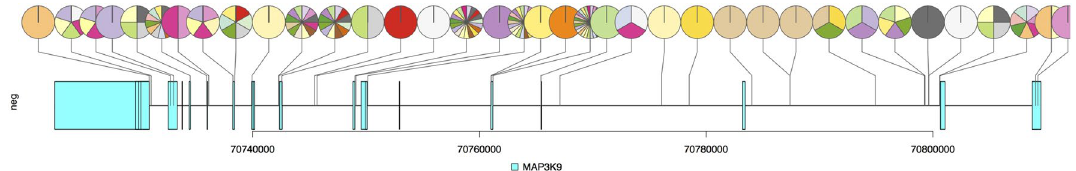
Figure 1. Genomic locations of SNVs in MAP3K9 . Figure 1 demonstrates the large number and locations of SNVs across the MAP3K9 gene. Exons are depicted as blue blocks. Thirty-seven unique SNVs were observed in total. Each pie chart portrays the number of patients who were found to have that specific variant at that genomic location. The color of each pie chart slice is specific to an individual patient and is conserved across all pie